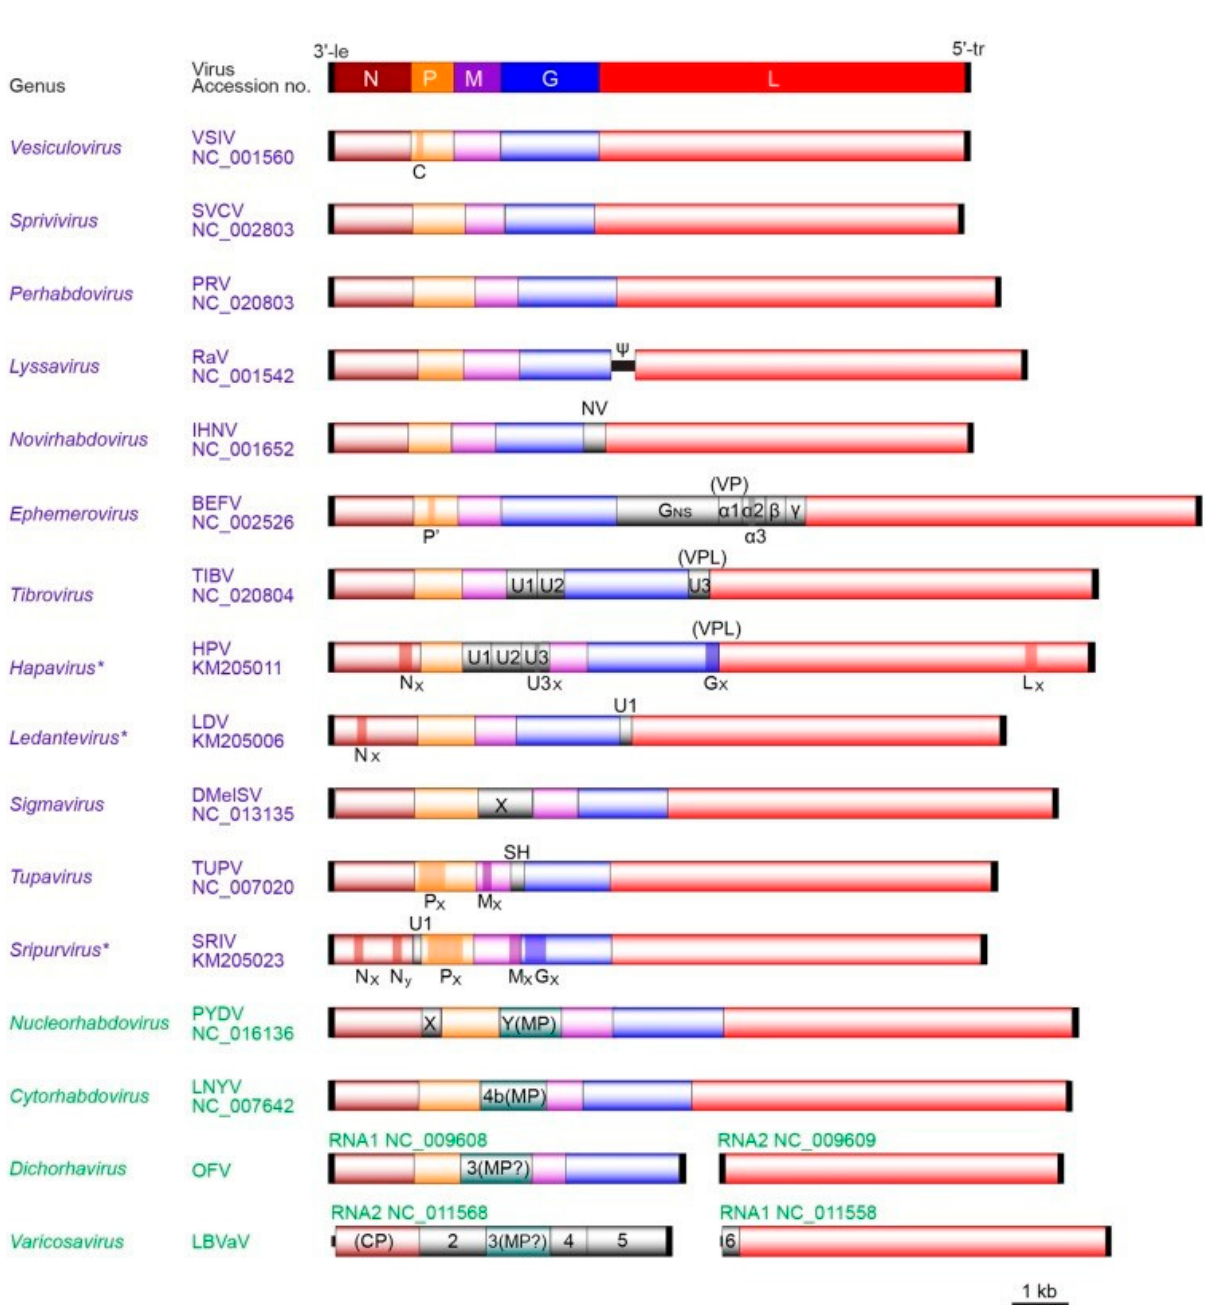
Figure 3. Comparative genome organisation of representative members from 16 genera of the family Rhabdoviridae. The five canonical structural protein genes (N, P, M, G and L) are presented in different colors. Other genes including movement protein (MP), viroporin (VP) or viroporin-like protein(VPL) and unknown function protein genes are seen in grey (Dietzgen et al., 2017 with